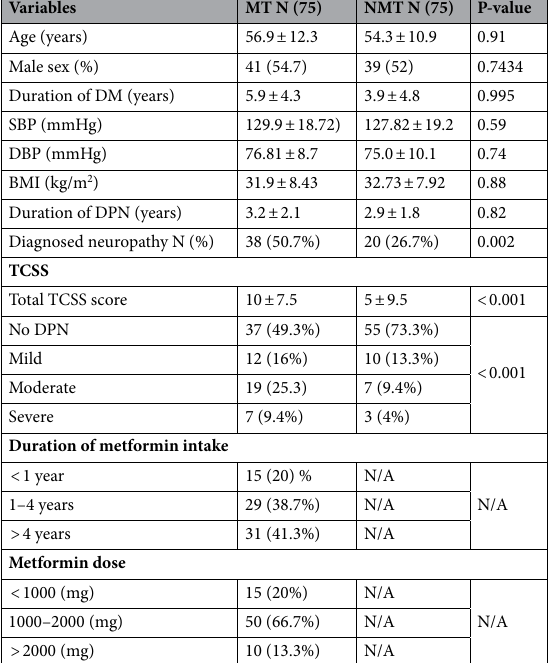
Table 1. Patients’ demographic and clinical characteristics, divided according to metformin use (N = 150). MT: metformin-treated, NMT: non-metformin-treated, SBP: systolic blood pressure, DBP: diastolic blood